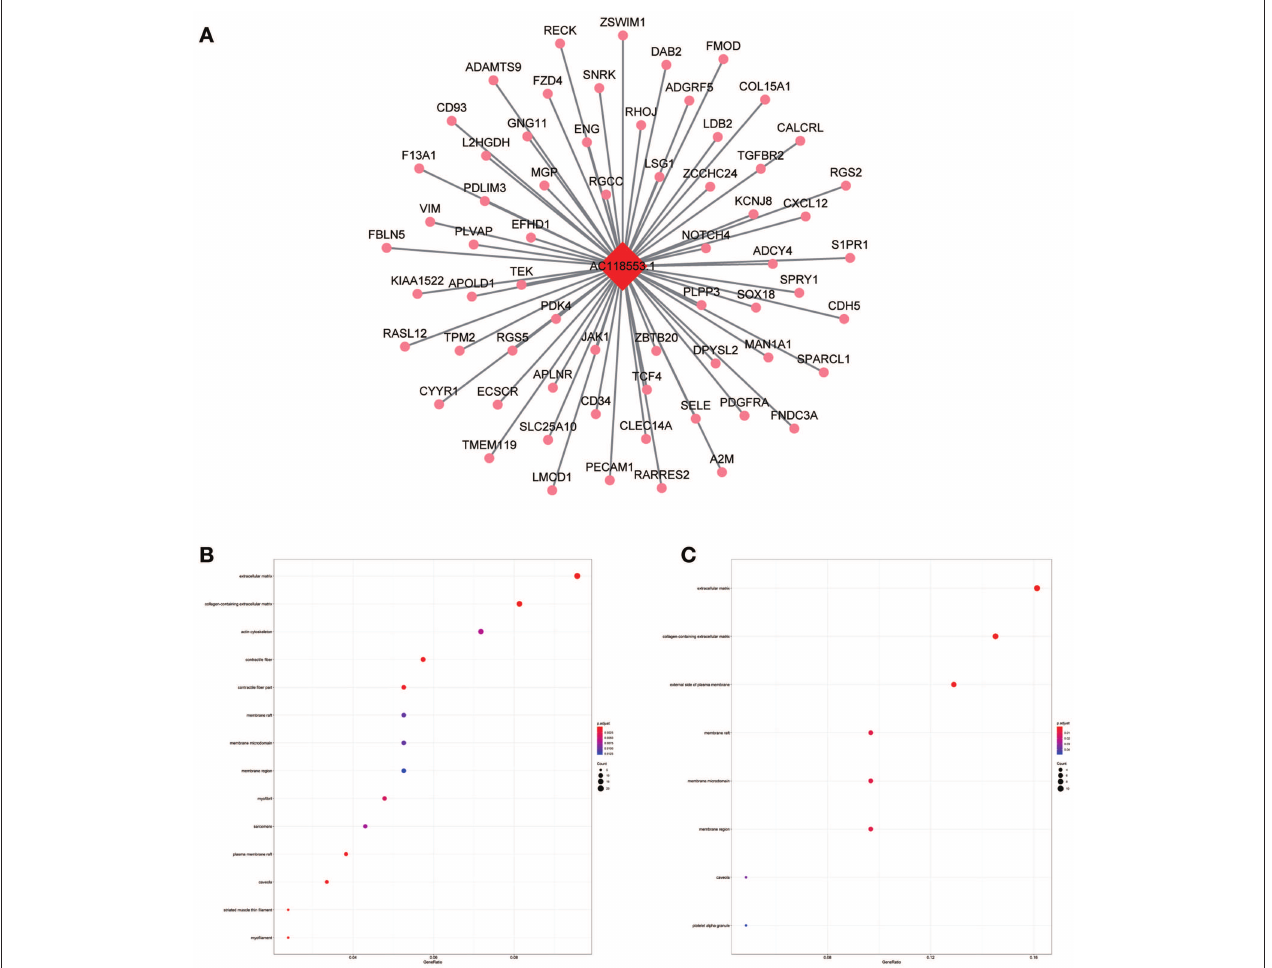
FIGURE 10 | LncRNA-mRNA network in Magenta module and functional enrichment. (A) The lncRNA-mRNA network in Magenta module, (B) GO-CC enrichment analysis (All genes in Magenta module), and (C) GO-CC enrichment analysis (AC118553.1 related genes in Magenta module).